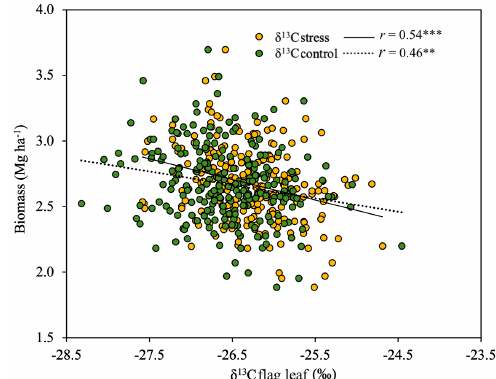
Figure 4. Linear regression of the relationship between the plant biomass at mid grain filling and the stable carbon isotope composition ( δ 13 C) in the flag leaf dry matter sampled before stress conditions were imposed ( δ 13 C control) and two weeks after the last irrigation ( δ 13 C stress). Level of significance, ** p < 0.01, *** p < 0.001.